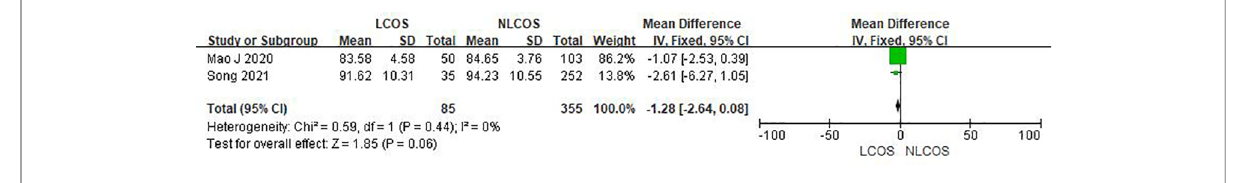
FIGURE 5 Preoperative oxygen saturation forest plot.